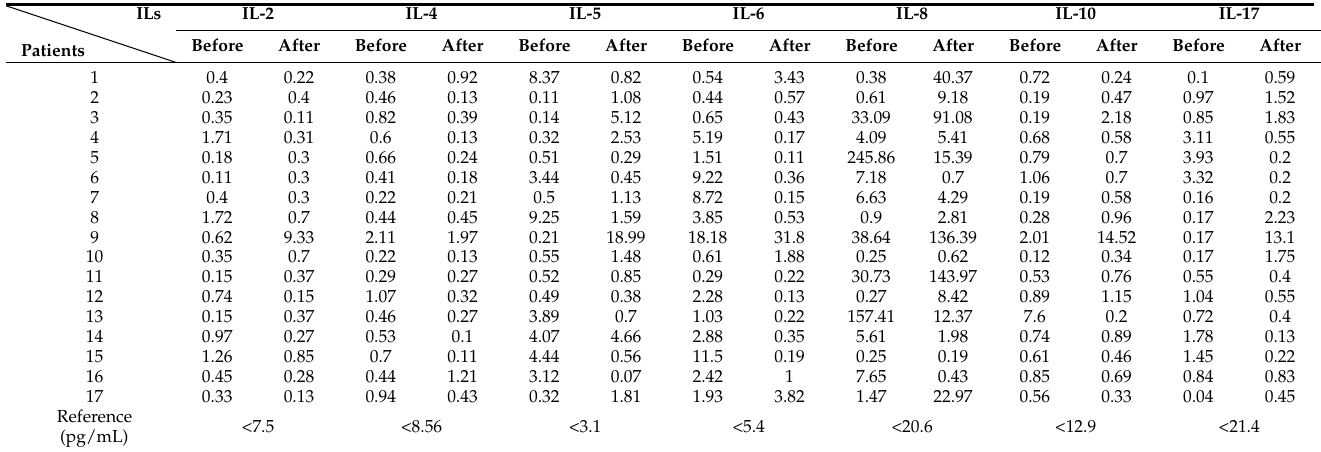
Table 3. Changes in ILs before and after